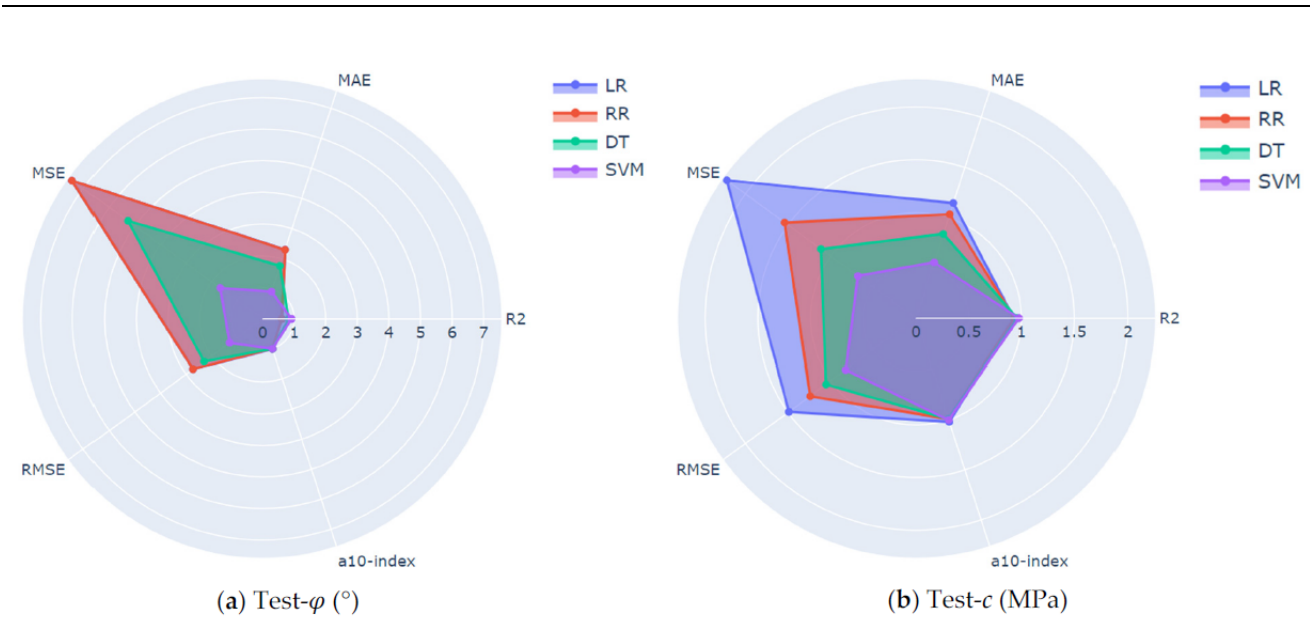
Figure 8. Radar plots of performance indices R 2 , MAE, MSE, RMSE, and a10-index of the developed predictive models for the ( a ) (cid:2030) (°) and ( b ) c (MPa) at the testing phase in this